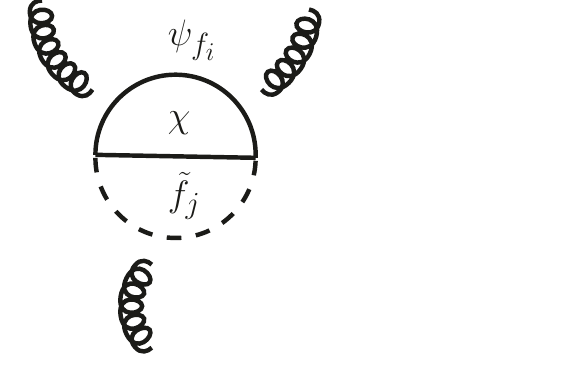
Figure 8 . Feynman diagram that induces the Weinberg operator. The gluon lines are attached to the vector-like quark and/or scalar